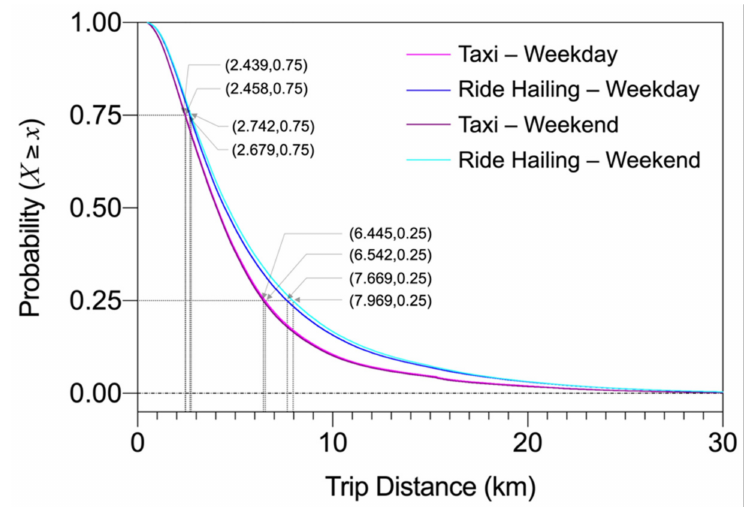
Figure 11. Distance decay of trips for each mobility-day